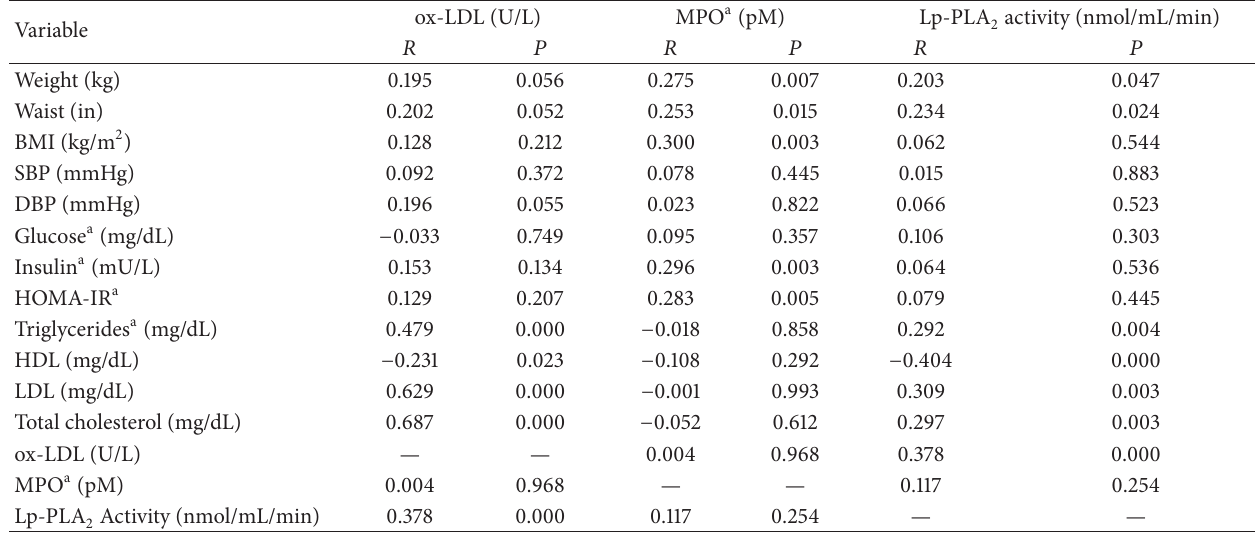
Table 2: Baseline correlations (Pearson’s regression) of several parameters with ox-LDL, MPO, and Lp-PLA without the metabolic syndrome ( 𝑛 = 100